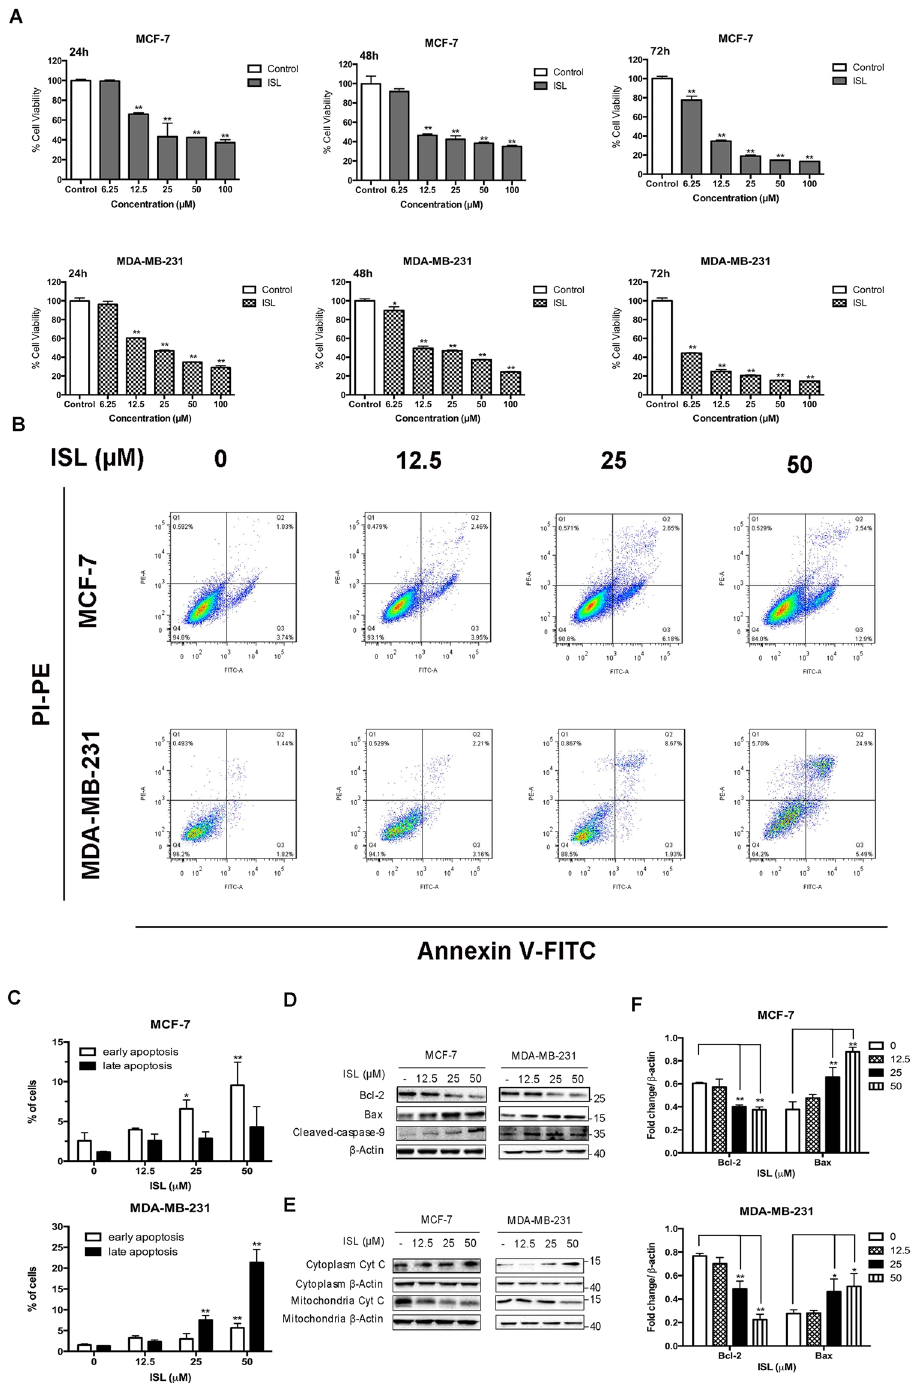
Figure 1. Effect of ISL on cell proliferation and apoptosis in breast cancer cells. ( A ) Cell viability of MCF-7 and MDA-MB-231 after 24 h, 48 h, 72 h ISL treatment. ( B ) Representative images of induction of apoptosis in breast cancer cells determined by Flow cytometry analysis cultured with ISL (12.5, 25, 50 μ M) for 24 h. ( C ) Percentages of early apoptotic cells and late apoptotic cells in different dose of ISL intervention according to Flow cytometry assay analysis. ( D , F ) Western blot analysis of Bcl-2, Bax, Cleaved Caspase-9, in MCF-7 and MDA-MB-231 after 24 h ISL treatment. The full-length blots were presented in the Supplementary Fig. 7. ( E ) Western blot analysis of Cyt C release in breast cancer cells after 24 h ISL interference. The full-length blots were presented in the Supplementary Fig. 8. Data represent the mean ± s.d. * P < 0.05, ** P <